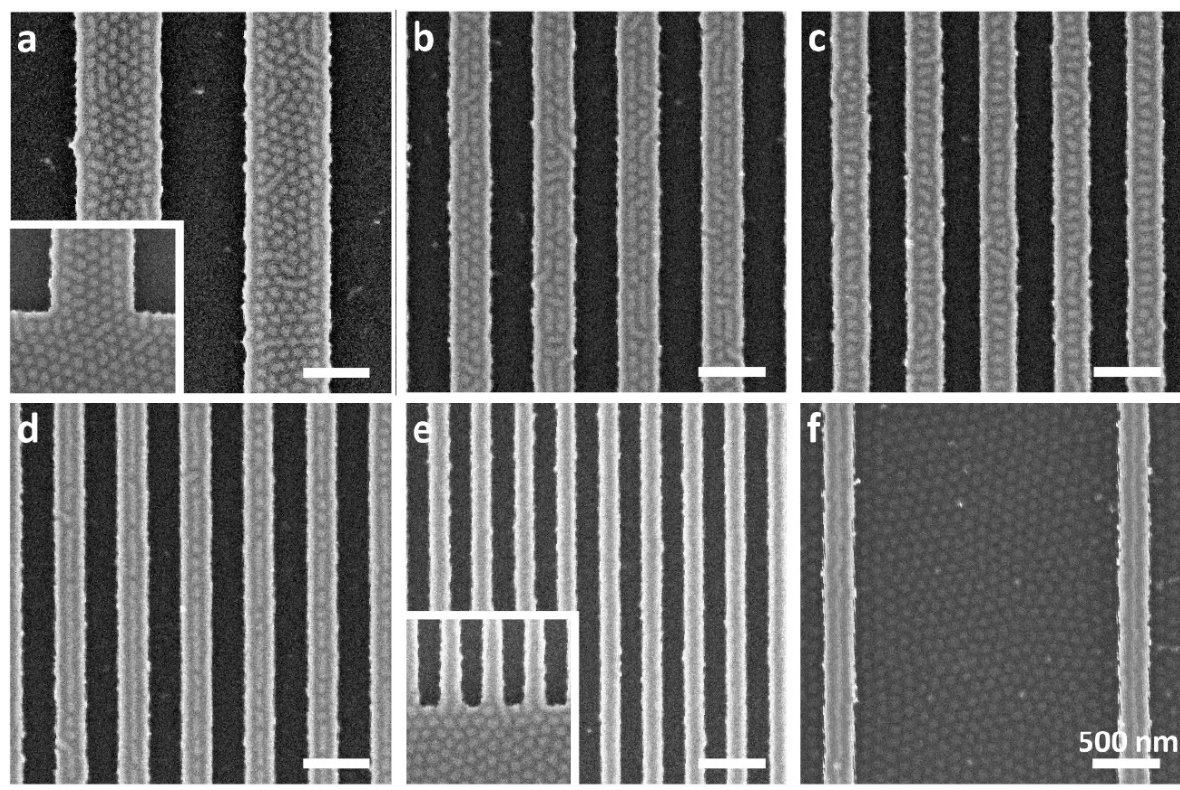
Figure 1. SEM images of samples with nominal 18 nm-thick BCP film annealed over a topographically patterned substrate featuring parallel plateaus and trenches (light and dark tones, respectively) with 38 nm deep trenches and variable trench/plateau widths: ( a ) 640/640 nm, ( b ) 320/320 nm, ( c ) 280/280 nm, ( d ) 240/240 nm, ( e ) 160/160 nm, and ( f ) 2000/240 nm. Insets in ( a , e ) show the edge of the patterned area. White domains (dots and stripes) correspond to PMMA. All scale bars represent 500 nm.